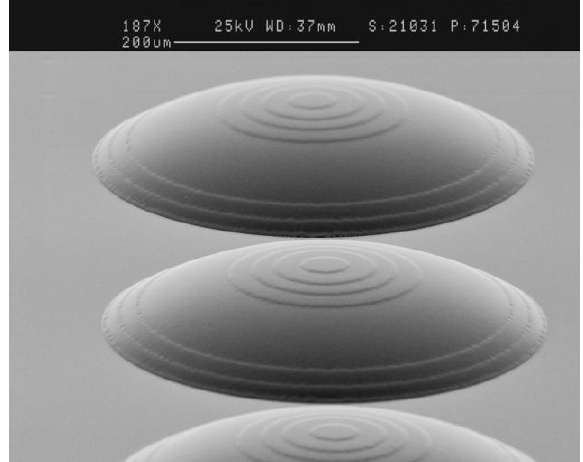
Figure 3. Mastering of hybrid microlenses: refractive lens combined with a diffractive phase correction element by combining reflow and laser